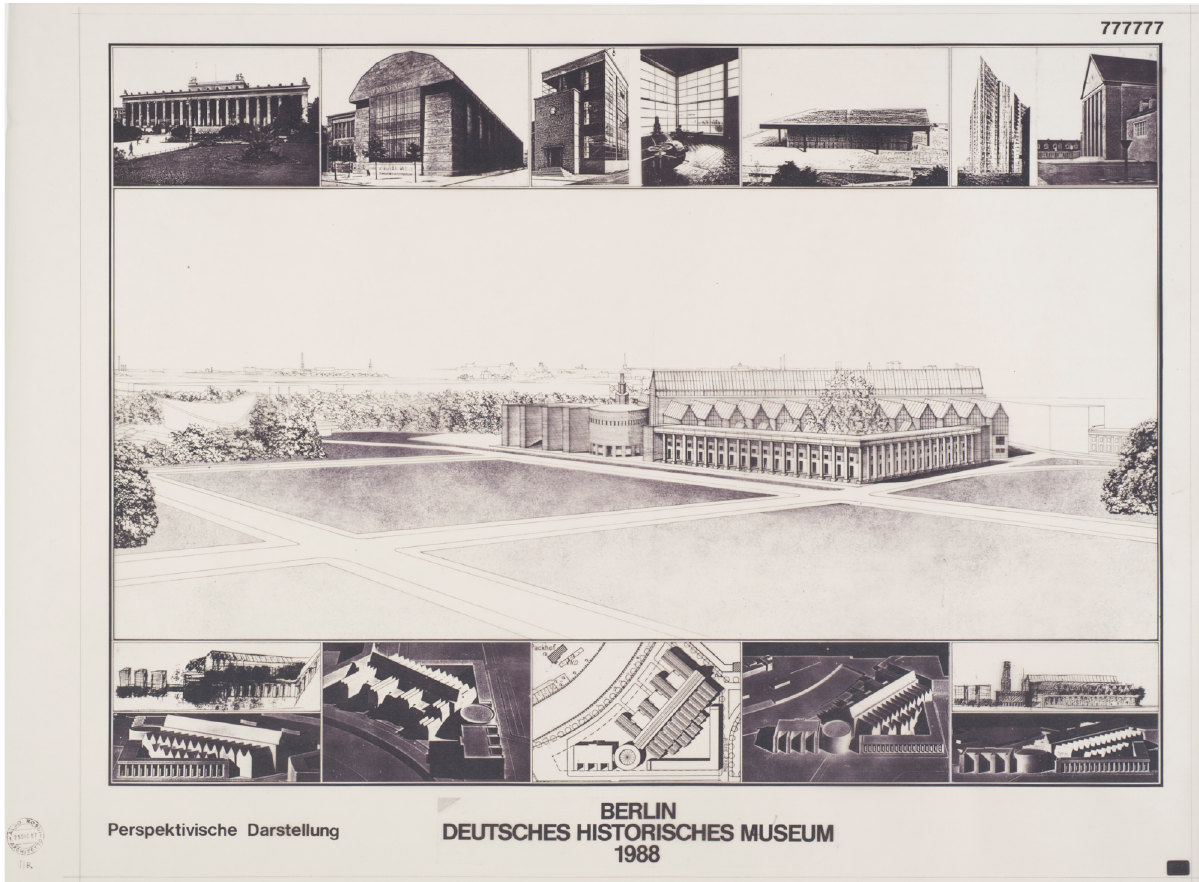
Panel of the Rossi Studio com- petition entry, framed above